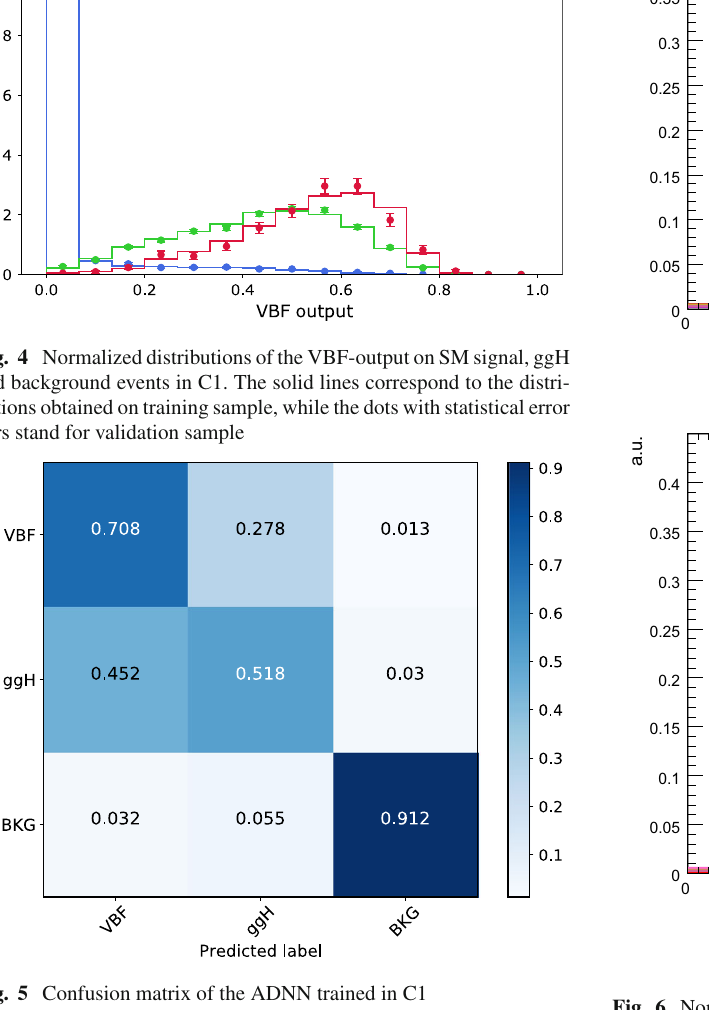
Fig. 6 Normalized distribution of the VBF-output of both the ADNNs in the corresponding STXS bin. The uncertainty associated with the limitedsize of simulated samples is reported only in the SM